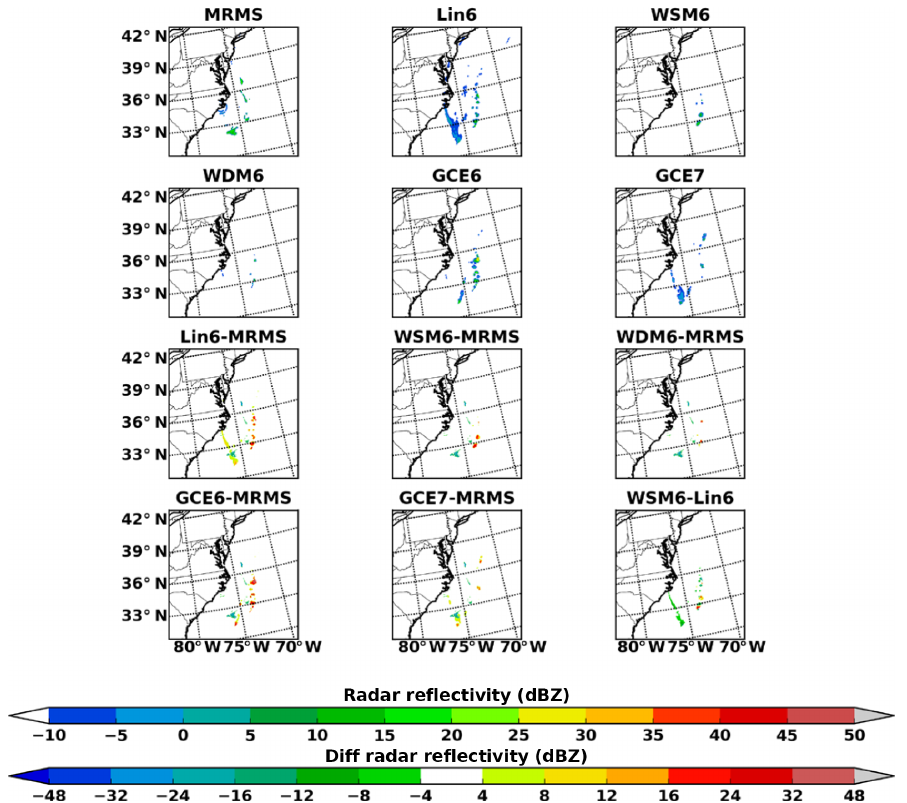
Figure 10. MRMS observed radar and WRF-simulated radar reflectivity (dBZ) at 9000m above sea level at 18:00UTC, 26 January 2015. Shown radar reflectivity differences are as